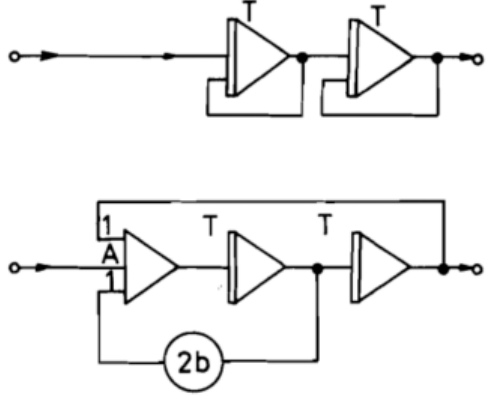
Figure 11. Schematic of the control system [56].